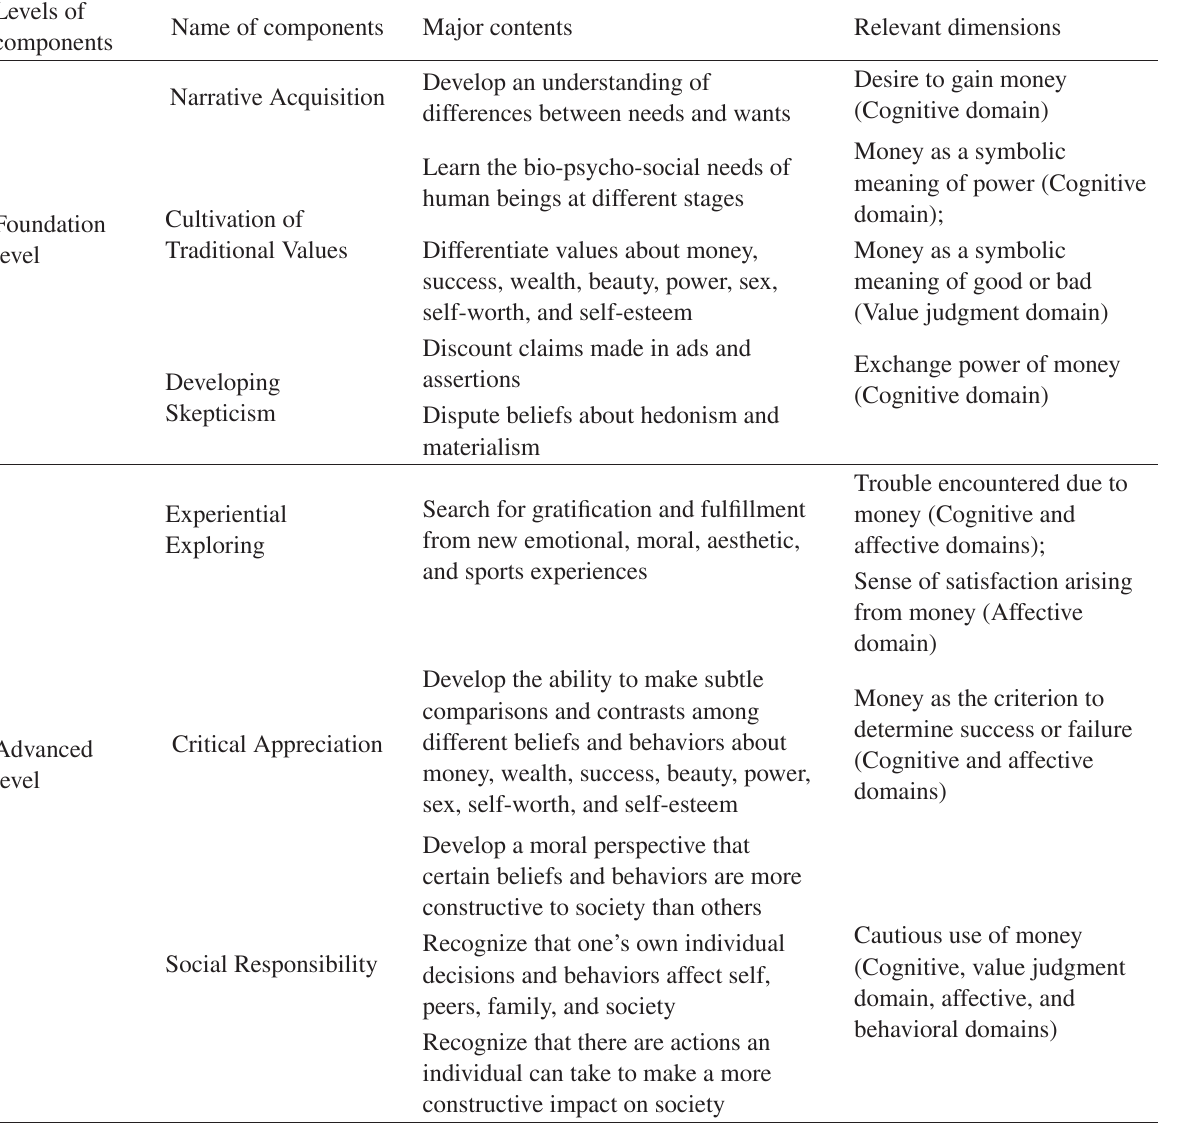
TABLE 1: A framework on money literacy for children and